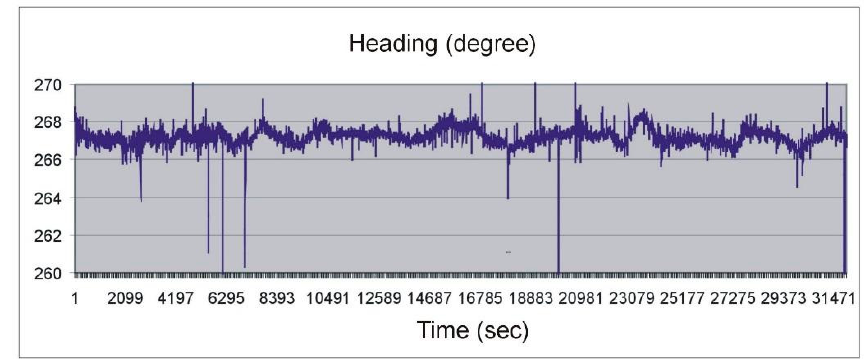
Figure 2. Heading measured with a satellite compass during stationary measurements [2].